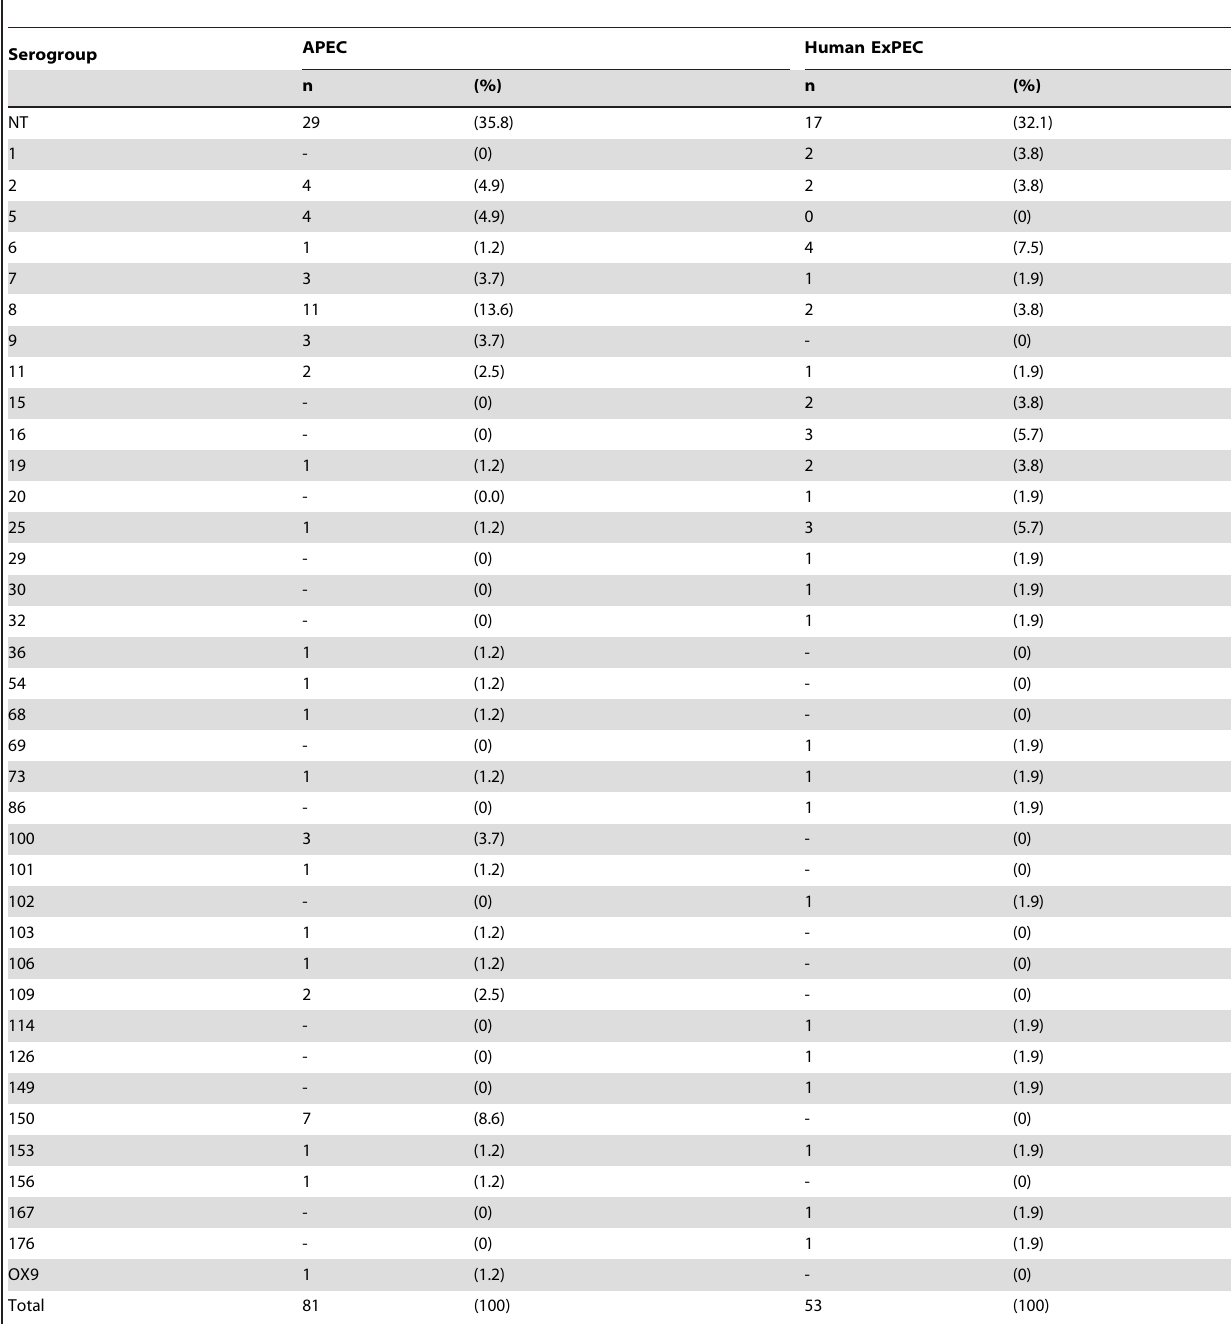
Table 2. Frequencies of O types among APEC (n=81) and ExPEC (n=53) strains isolated in Brazil.